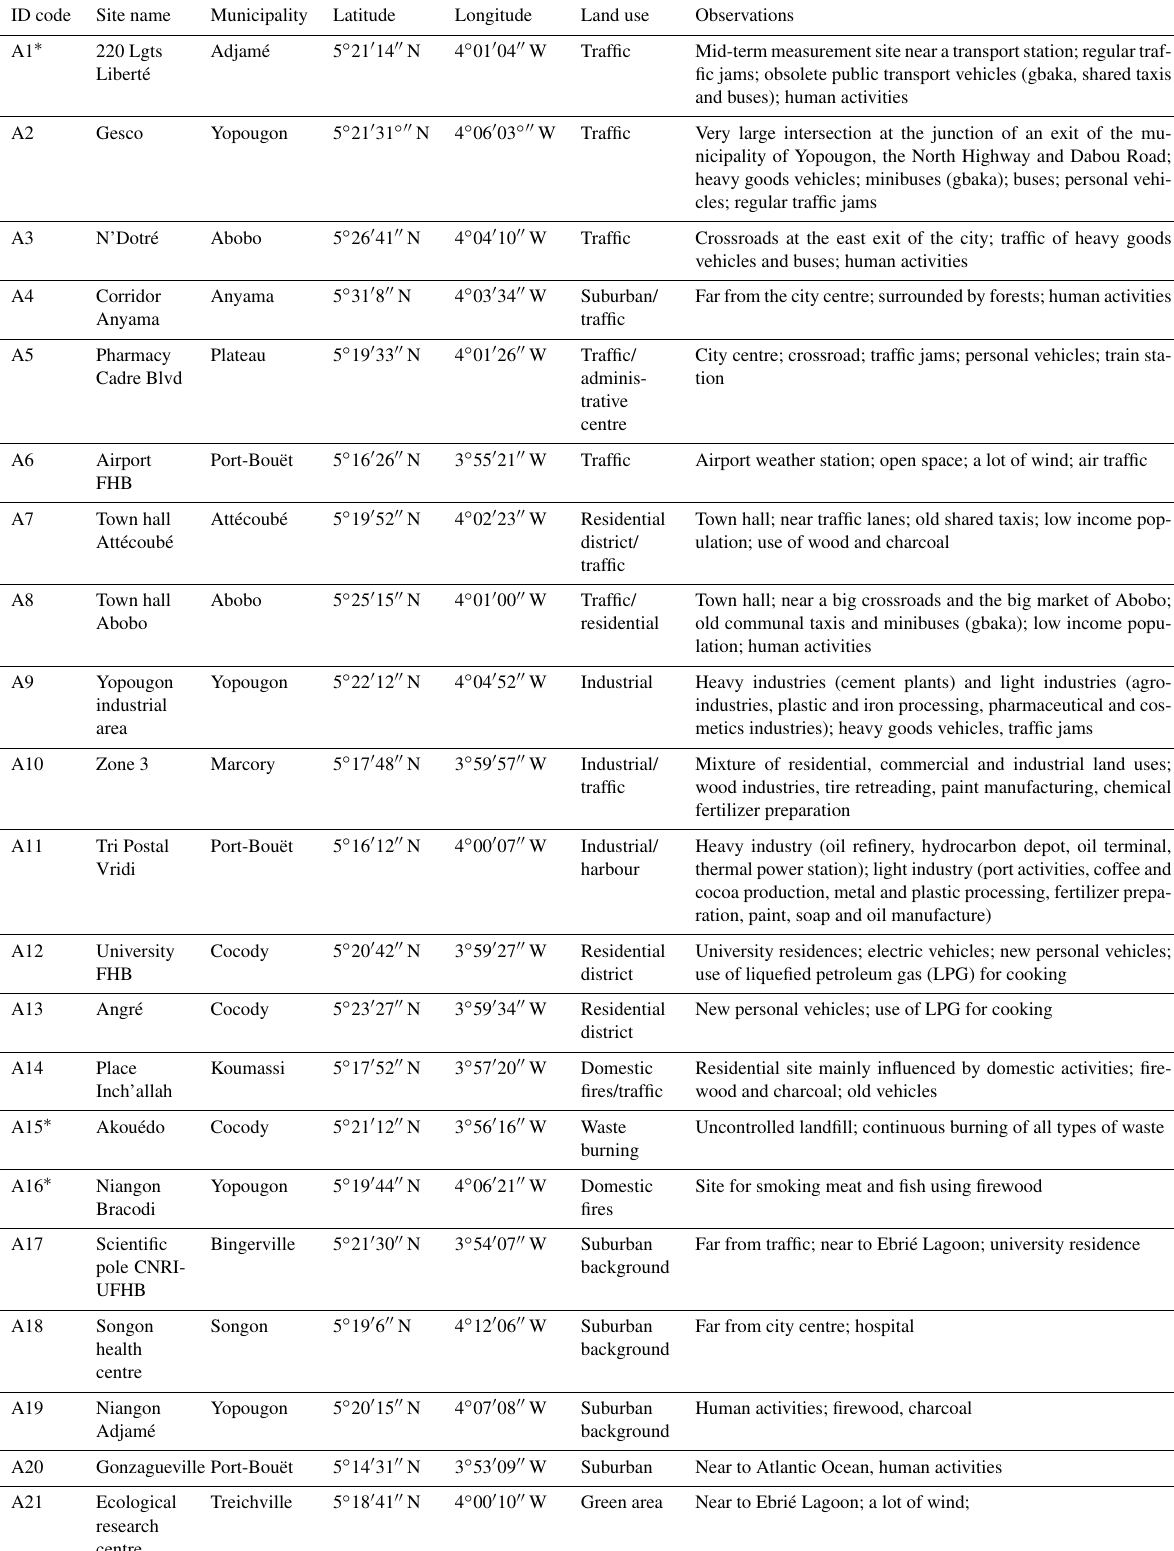
Table 1. Geographical coordinates of sampling sites and majors source of air pollution nearby. ID